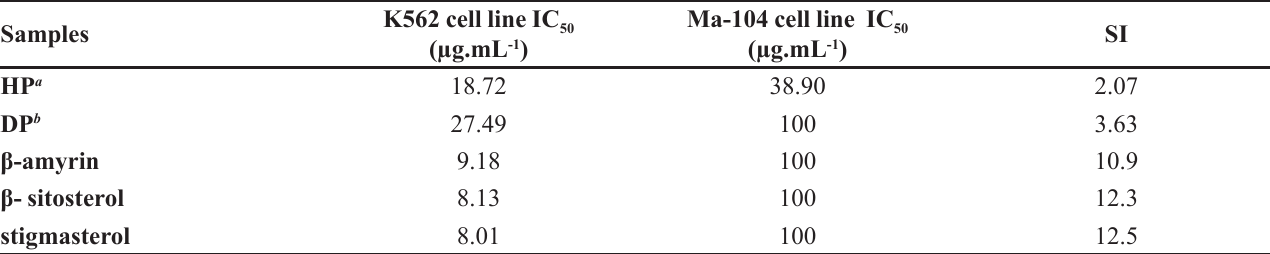
MA-104 / IC K562 50 50